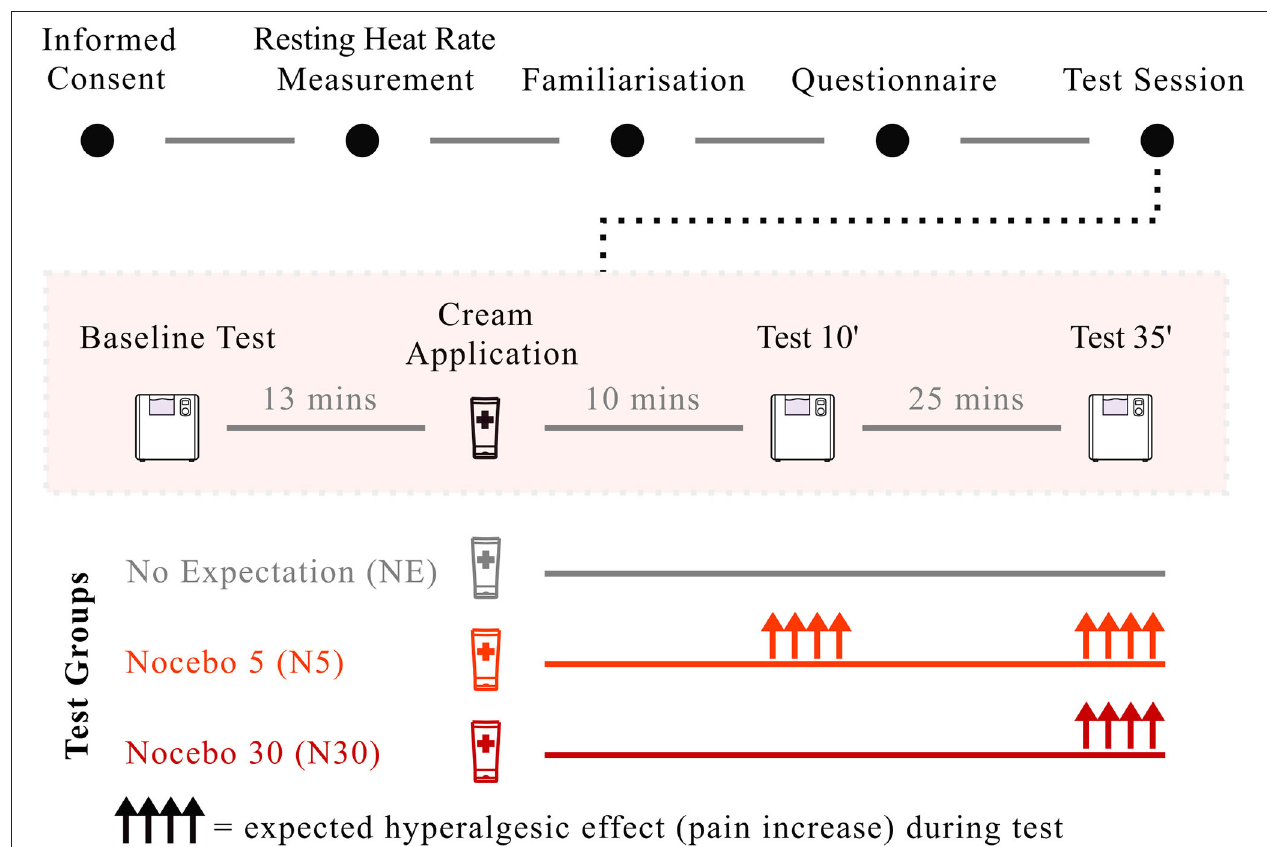
FIGURE 2 | Study paradigm. After giving consent, participants’ heart rate at rest was measured for 4min. Participants completed the CPT familiarisation run and filled in the psychological questionnaires. After the CPT baseline test, the cream was applied along with suggestions of hyperalgesia (N5, Bright red; N30, Dark red) and neutral suggestions (NE), depending on group randomisation. Application of the cream and the delivery of suggestions took 10 and 35min from cream application. Nocebo hyperalgesia, visualised as upper-facing arrows in the image, was expected both at Test 10 and at Test 35 for N5, and only at Test 35 for N30. No effect was expected for